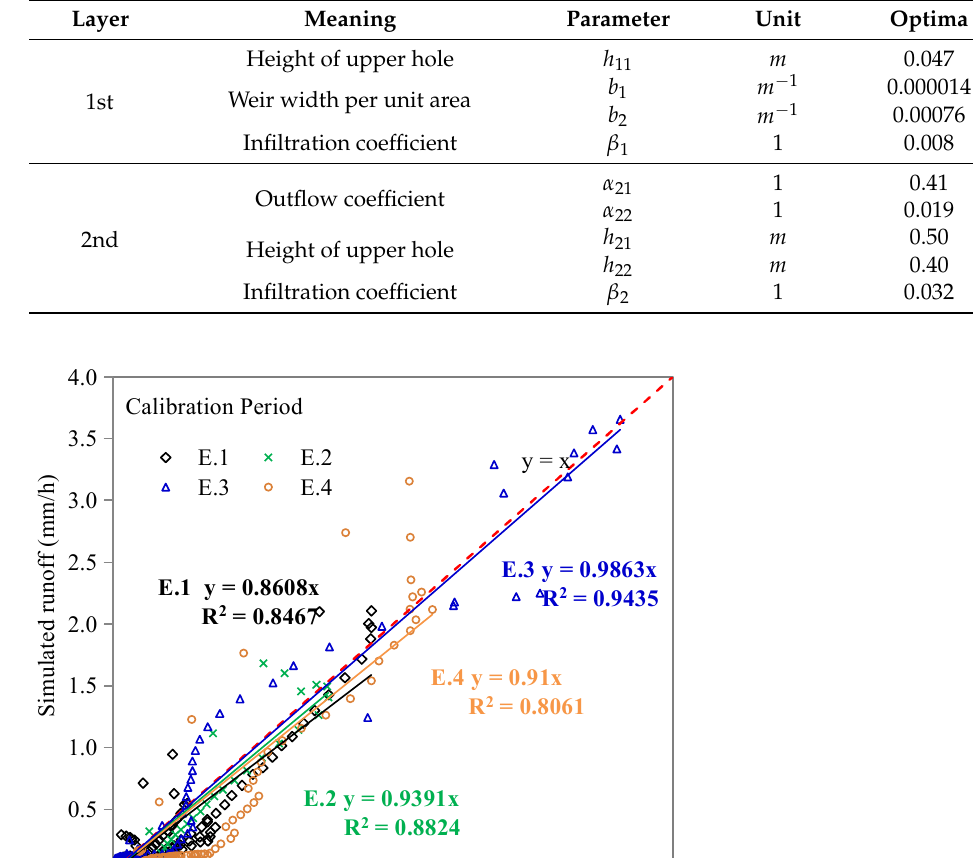
Table 5. The optimizing results of Tank model parameters.